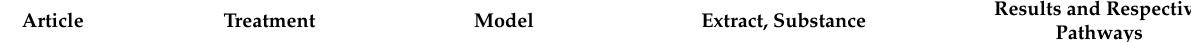
Table 7. Summary of metabolic effects mediated by plant-based polyphenols and respective pathways. Oleic acid (OA). Mouse insulinoma 6 (MIN6). Glutathione peroxidase (GPx). Free fatty acids (FFA). Glucagon-like peptide 1 (GLP-1). Dipeptidylpeptidase-4 (DPP4). Reactive oxygen species (ROS). Superoxide dismutase (SOD). Triglyceride (TG). Palmitic acid (PA). Insulinoma (INS-1). Pancreatic and duodenal homebox 1 (Pdx1). Extracellular-signal-regulated kinase (ERK). Glucose-stimulated insulin secretion (GSIS). Endoplasmic reticulum (ER). Insulin receptor substrate 1 (IRS-1).